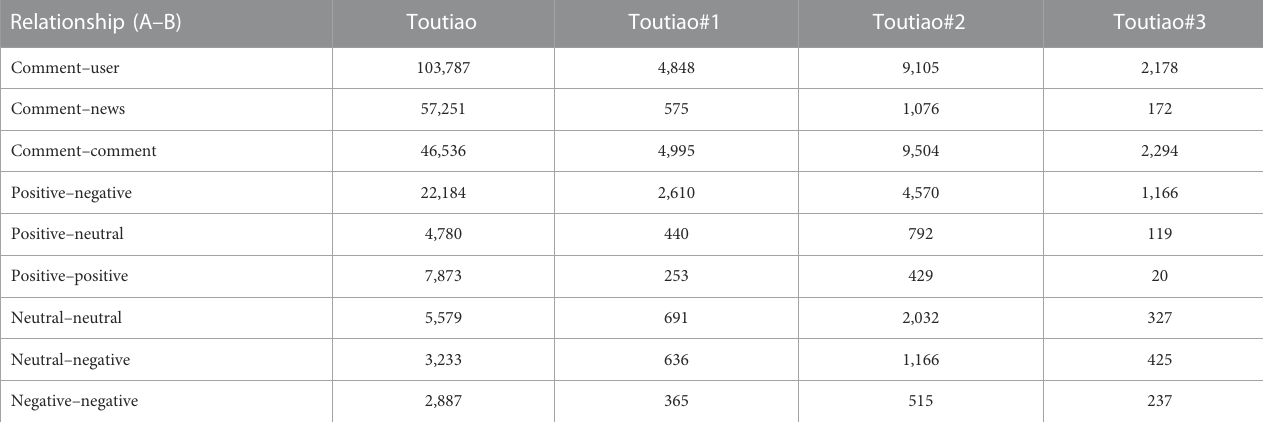
TABLE 2 Different types of interactions over the Toutiao dataset and its